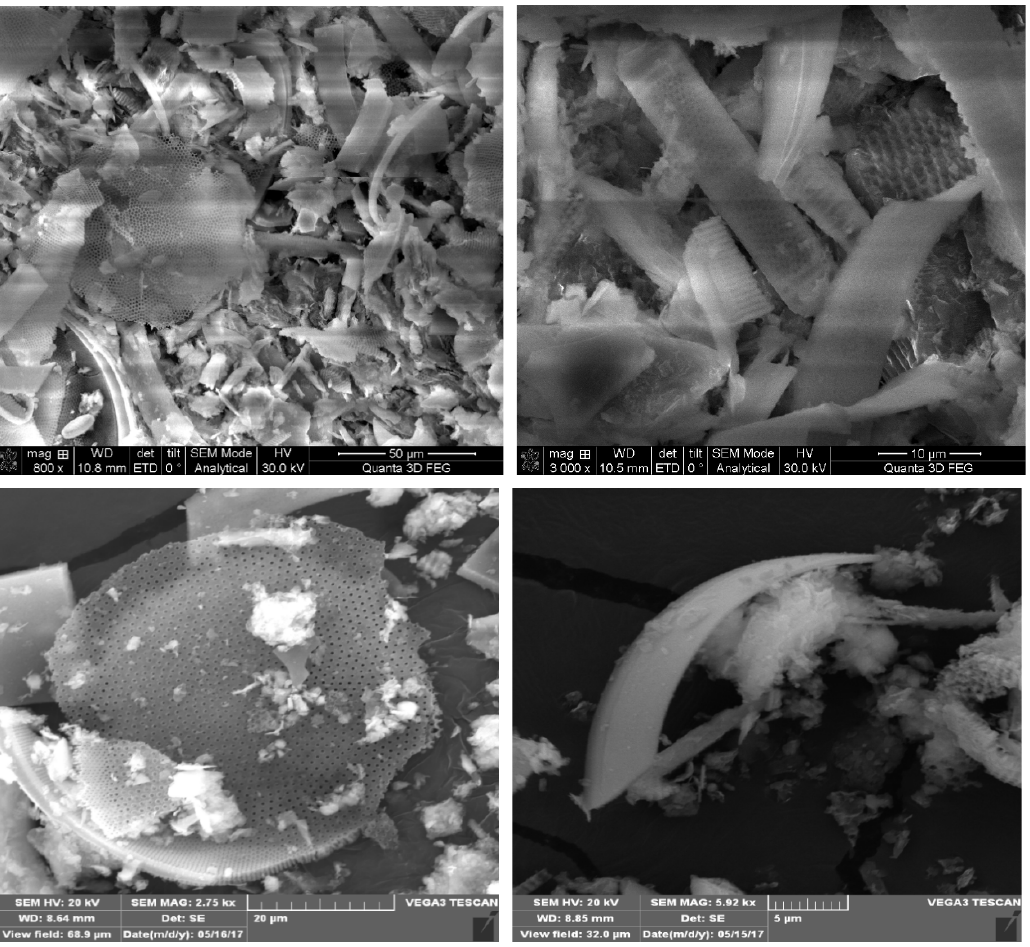
Figure 4: SEM pictures of raw trepel composed of various microrelics of biogenetic origin with various forms (globular or tubes) with many pores ranging from 350 – 650 nm.